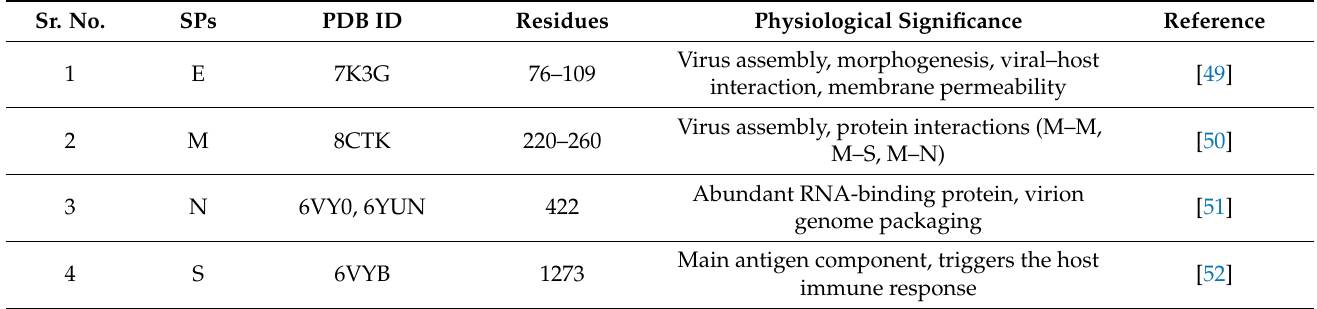
Table 1. The structural proteins (SPs) of coronaviruses and their physiological significance. Sr. No.